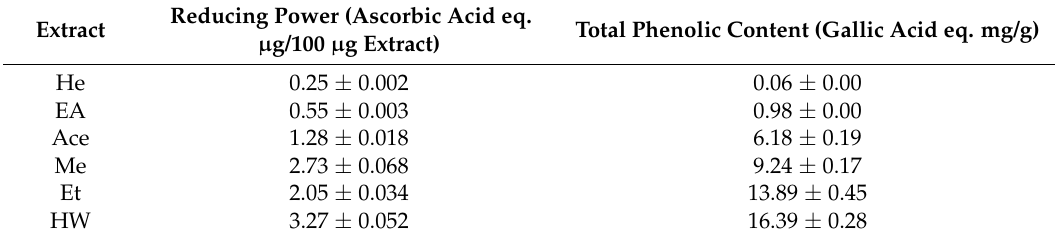
Table 1. Reducing power and total phenolic contents of C.yabunikkei leaf extracts.